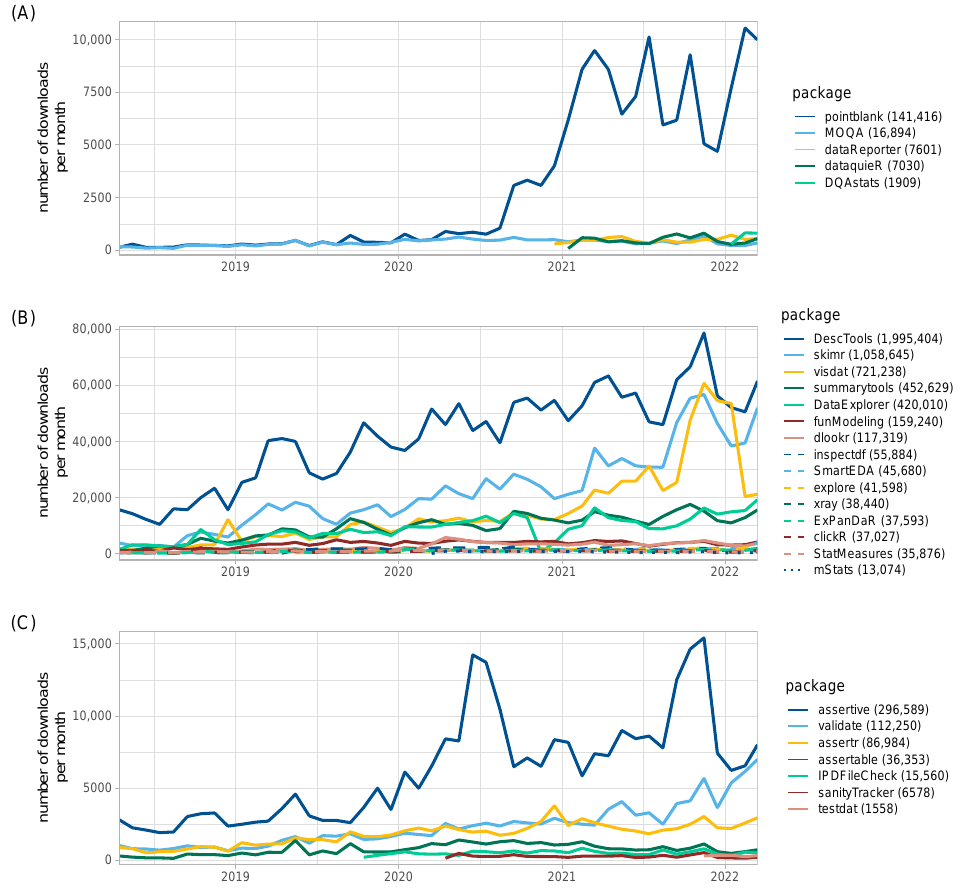
Figure 5. CRAN downloads per month from April 2018 to March 2022 for ( A ) packages with focus on DQA, ( B ) packages for descriptive statistics, data exploration, and statistical analysis, and ( C ) rule- based packages. Numbers in the legend report the total number of downloads in this time period (numbers of downloads retrieved using cranlogs